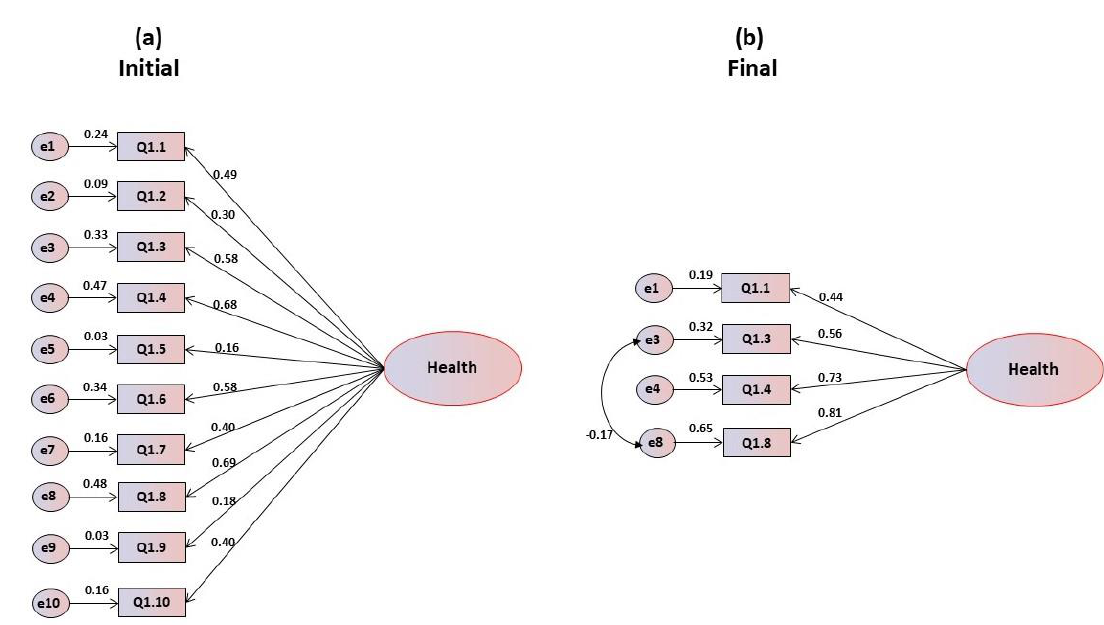
Figure 1. ( a ) Initial and ( b ) final models for the health motivations’ scale.